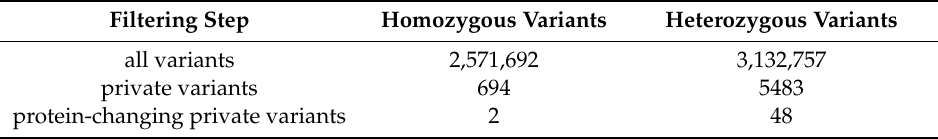
Table 1. Results of variant filtering in a brown (cocoa) French Bulldog and 655 control genomes.